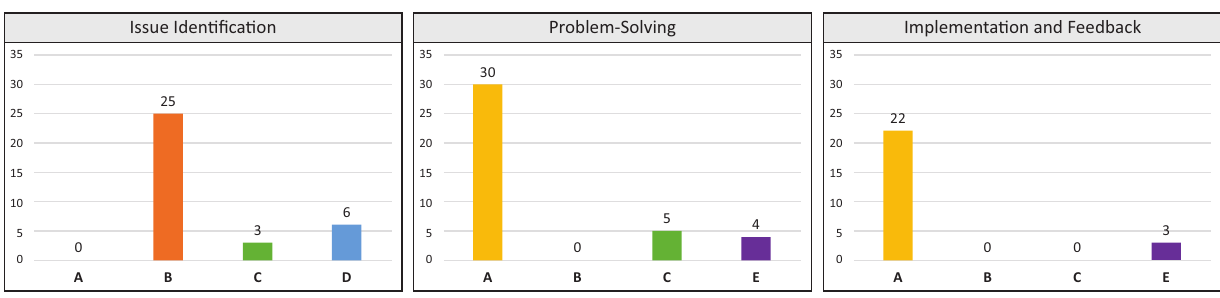
Figure 3. The percentage of local SCPs using citizen participation tools in the three stages. Notes: A—living lab only; B—living lab and survey; C—living lab and others (idea competition, advisory online platform, SNS, etc.); D—survey only; E—others.